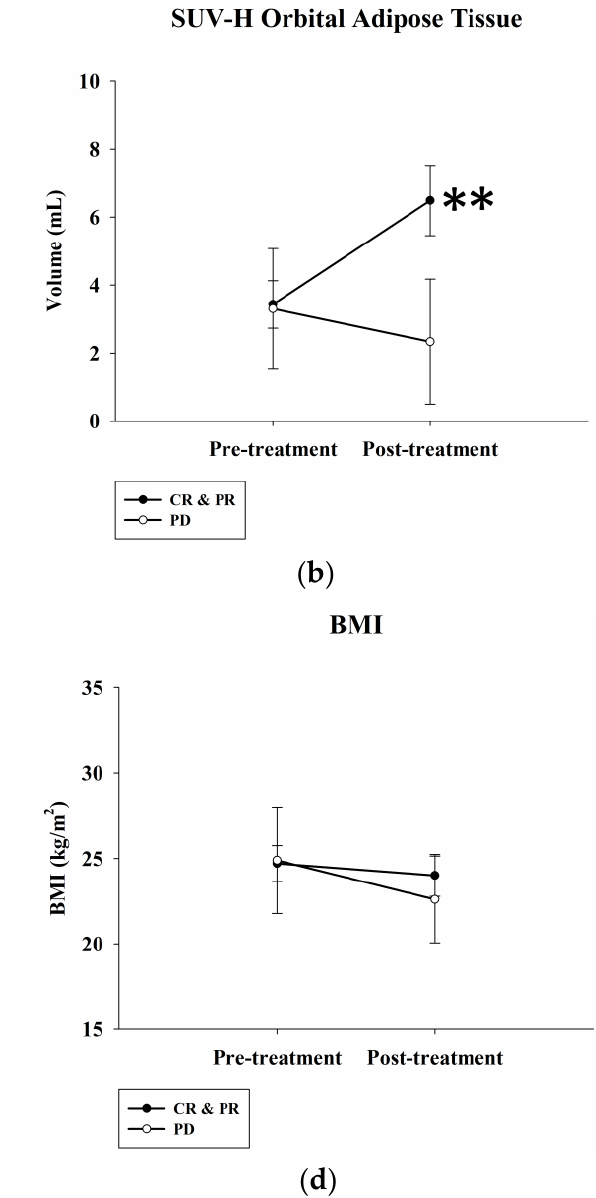
( h ) Figure 1. Pre- and post-treatment SUV-H EAT and SUV-H OAT for patients with different treatment responses, demonstrated by PET/CT viewer. ( a ) Pre-treatment and ( b ) post-treatment SUV-H EAT are shown in blue for a patient with CR. ( c ) Pre-treatment and ( d ) post-treatment SUV-H OAT are presented in orange for the same patient with CR. ( e ) Pre-treatment and ( f ) post-treatment SUV-H